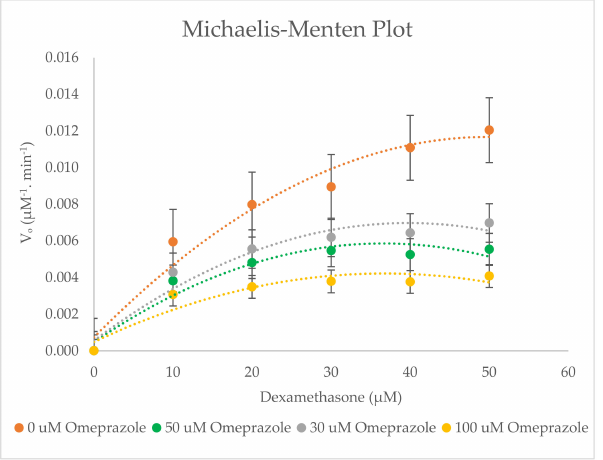
Figure 10. Michaelis − Menten plot for the inhibition of CYP3A2 − catalysed dexamethasone 6 − hydroxylation by omeprazole (0 − 100 µ M). The polynomial function of order 2 was used to fit the curves. Values are expressed as the average of triplicate